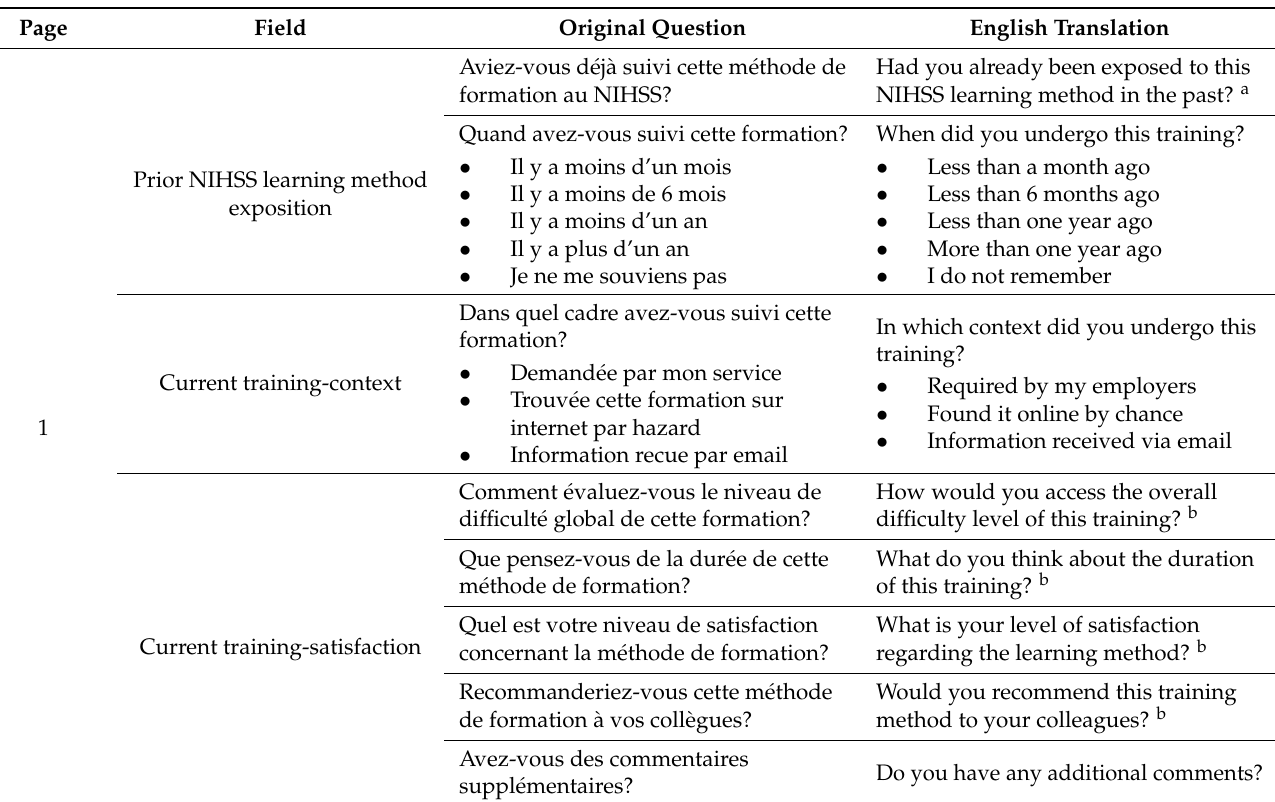
Table 2. Post-course